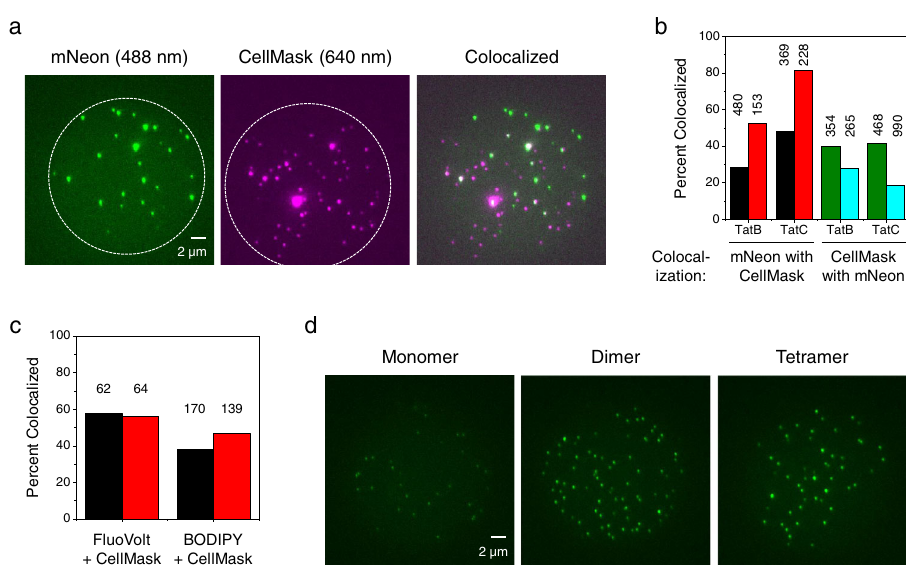
Fig. 3 Single particle imaging of IMVs with TatABC mNeon and mNeon standards. a Adherent IMVs. IMVs containing TatABC mNeon stained with the CellMask lipid dye were visualized on coverslips using 488 nm (mNeon, green channel) and 640 nm (CellMask, red channel) excitation. The mNeon was imaged fi rst and photobleached before imaging with the red channel. A very low amount of the free CellMask dye sticks to the coverslip surface (Supplementary Fig. 3), indicating that CellMask reports on the presence of material in the IVM preparation. IMVs with wildtype TatABC exhibit almost no fl uorescence in the green channel (Supplementary Fig. 4). Only colocalized spots (TatC mNeon within a CellMask-positive entity) were used for photobleaching analysis. The IMVs imaged here were obtained from cells in which TatABC mNeon was overproduced for 1 h with 0.7% arabinose. IMVs prepared in this manner yielded an ~50% colocalization of mNeon with CellMask. This colocalization percentage is not increased with a 10-fold higher concentration of CellMask (Supplementary Fig. 5). The dashed white circles indicates the approximate illumination area using narrow- fi eld epi fl uorescence 47 . By including a “ 2 h chase ” during cell growth, the number of mNeon spots per fi eld decreased but the colocalization percentage with CellMask increased (Supplementary Fig. 6). b Colocalization percentages of labeled Tat proteins and CellMask. IMV preparations containing TatAB mNeon C or TatABC mNeon were incubated with CellMask, and then visualized in the green and red channels. Quanti fi ed are: (i) spots visualized in the mNeon channel that were CellMask-positive using IMVs from 1 h (black) or 1 h + “ 2 h chase ” (red) TatABC overproduction times; and (ii) spots visualized in the CellMask channel that were mNeon-positive using IMVs from 1 h (green) or 1 h + ‘ 2 h chase ’ (blue) TatABC overproduction times. Numbers indicate the total number of spots identi fi ed with the primary fl uorophore. c Colocalization percentages of the FluoVolt and BODIPL-FL C16 dyes with CellMask. IMVs generated from wildtype TatABC overproduced for 1 h were co-incubated with two hydrophobic fl uorescent stains, as indicated (see Supplementary Fig. 7). Data were quanti fi ed as the FluoVolt- or BODIPY FL C16-positive spots colocalizing with CellMask (black) and the CellMask-positive spots colocalizing with FluoVolt or BODIPY FL C16 (red). Numbers indicate the total number of spots identi fi ed with the primary fl uorophore. CellMask (0.1×) and FluoVolt (2×) were used at the indicated dilutions of manufacturer stocks; BODIPY FL C16 was used at a fi nal concentration of 100 pM from a DMSO stock. d Coverslip-adsorbed mNeon standards. Shown are monomer (Cys-free mNeon), dimer (disul fi de dimer of mNeonC), and tetramer (disul fi de dimer